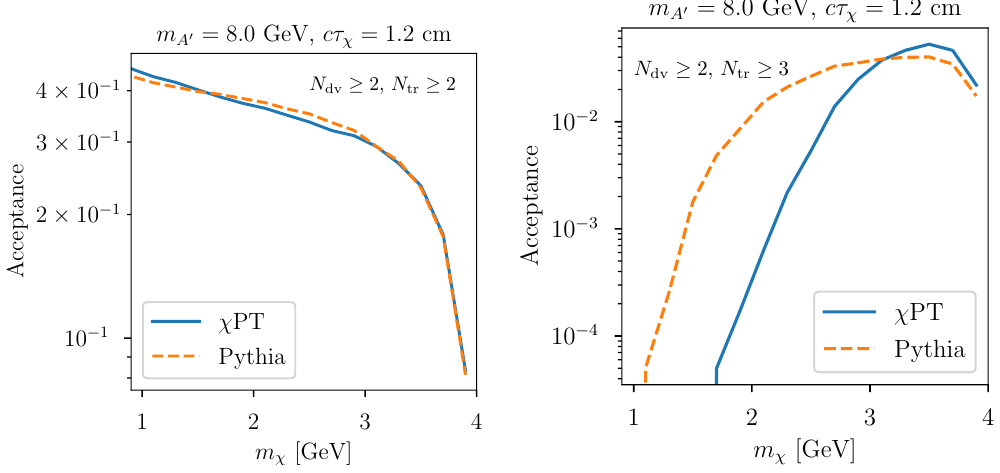
Figure 16 . Comparison of LLP signal acceptances evaluated in two different hadronization models of χ → νe + ¯ ud for m = 8 GeV and cτ 1 cm . In the left (right) panel we show the N A 0 χ ≈ N tr ≥ 2 ( N dv ≥ 2 , N tr ≥ 3 ) analyses. The solid blue lines show acceptances for final state generated using chiral perturbation theory/hidden local symmetry approach, while the orange dashed lines were obtained using Pythia